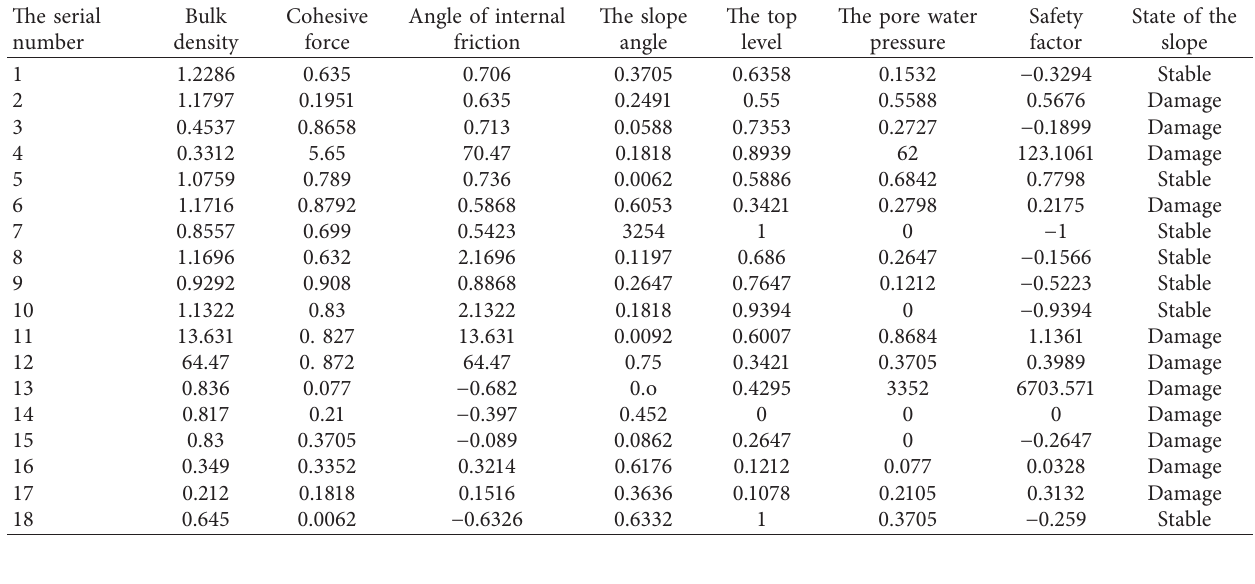
Table 2: The model parameters and the forecast results.